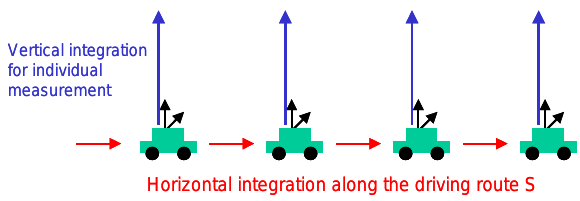
Fig. 1. From MAX-DOAS observations the vertically integrated Fig. 1 Form MAX-DOAS observations the vertically integrated tropospheric trace gas tropospheric trace gas concentrations can be determined. If MAX- concentrations can be determined. If MAX-DOAS observations are performed on mobile DOAS observations are performed on mobile platforms, a second platforms, a second integration along the driving route becomes possible (indicated by the integration along the driving route becomes possible (indicated by blue arrows). The black arrows indicate the viewing directions of the MAX-DOAS the blue arrows). The black arrows indicate the viewing directions instrument. of the MAX-DOAS